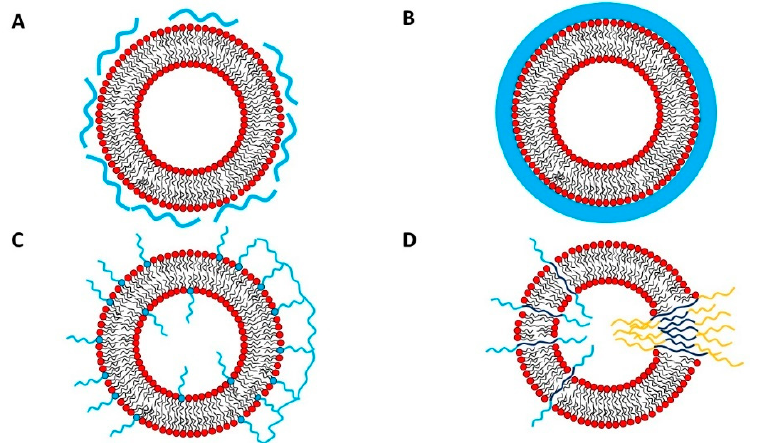
Figure 1. Polymer/liposome assembly. ( A ) Hydrophilic polymers are physically adsorbed onto liposome surface; ( B ) polymers are polymerized or undergo a phase change, trapping the vesicles inside; ( C , left ) polymers are covalently bonded to the polar head of phospholipids; ( C , right ) polymerizable monomers are reticulated to form a network surrounding the vesicles; ( D , left ) amphiphilic polymers are homogeneously distributed in the bilayer or ( D , right ) segregated in separate domains.